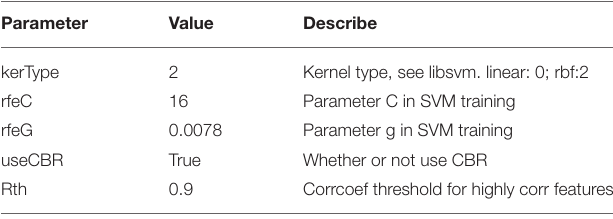
TABLE 1 | Parameter description in the SVM-RFE